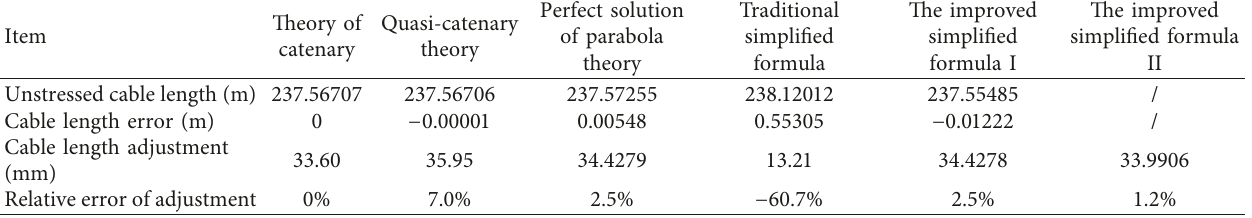
Table 1: Comparison of the calculation results of the unstressed length and cable length adjustment.